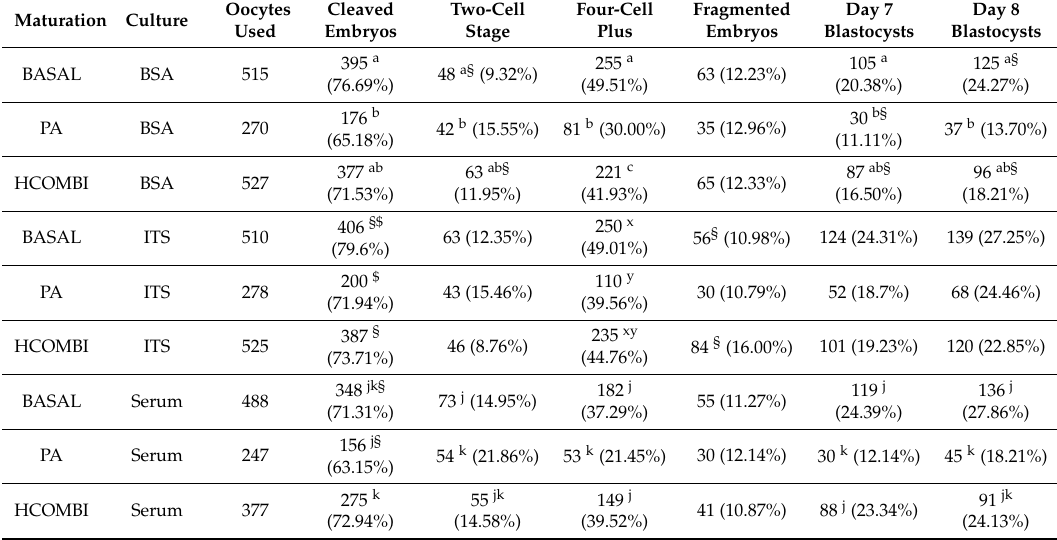
Table 1. The e ff ect of insulin-transferrin-selenium (ITS) or serum supplementation during in vitro culture (IVC) on the developmental competence of oocytes matured under metabolic stress conditions (PA (high palmitic acid) or HCOMBI NEFAs (a combination of pathophysiological, high concentrations of non-esterified fatty